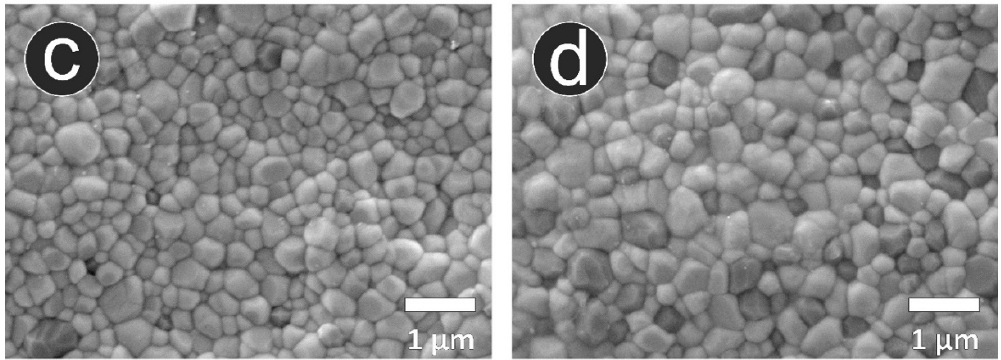
Figure 4. Representative SEM photomicrographs. ( a ) subtractively manufactured 3Y-TZP (LAVA Plus, 3M Oral care); ( b ) additively manufactured 3Y-TZP (LithaCon 3Y 230, Lithoz); ( c ) additively manufactured 3Y-TZP (3D Mix zirconia, 3DCeram Sinto); ( d ) additively manufactured ATZ (3D Mix ATZ, 3DCeram Sinto).